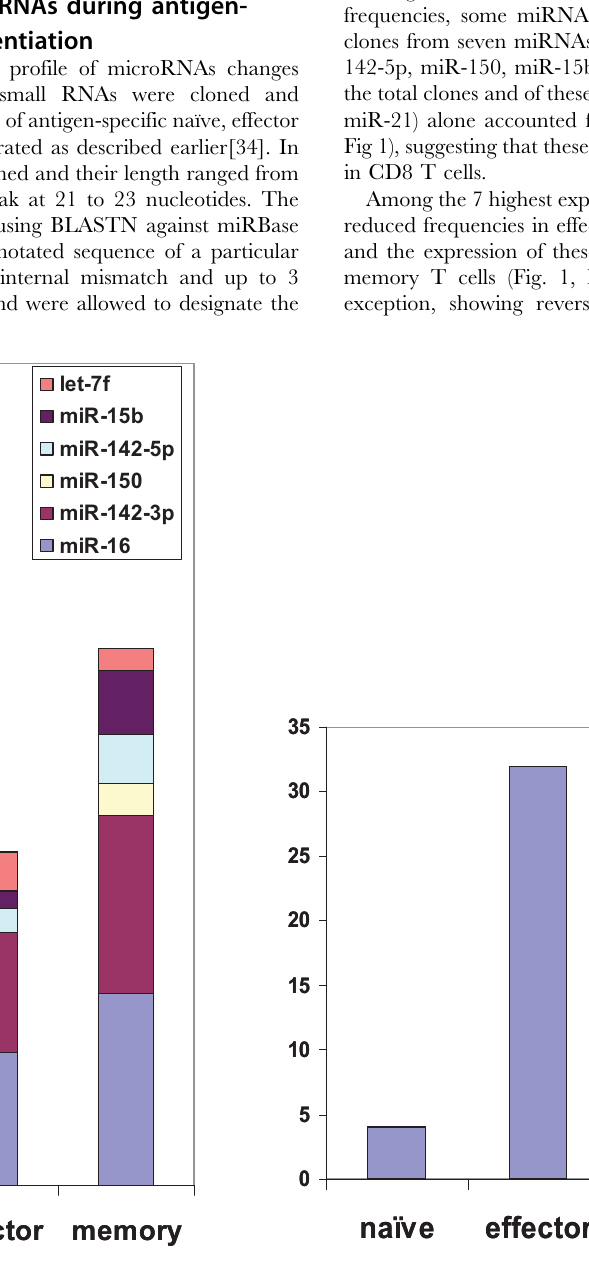
Figure 1. Distribution of the seven highly expressed miRNAs in the T cell subsets. The cloning frequency of each miRNA is shown as a percentage of total miRNA clones isolated for each T cell